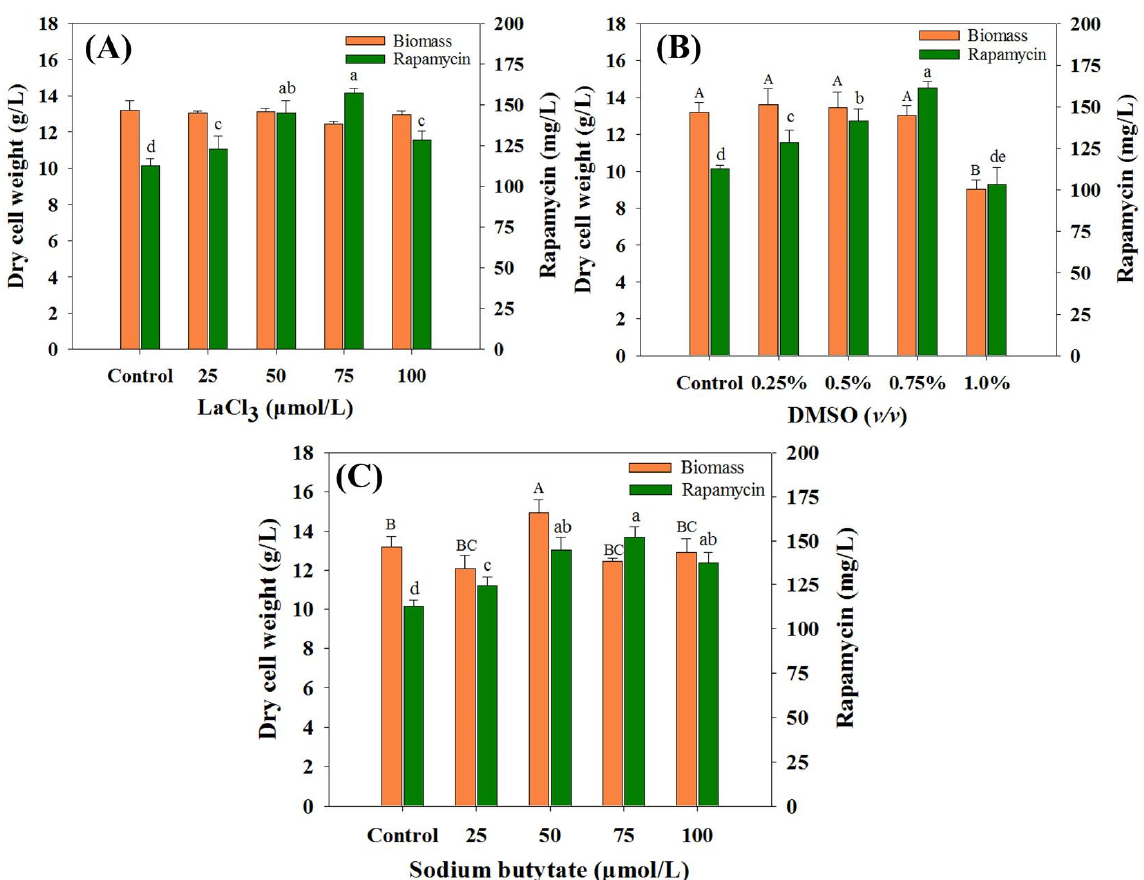
Figure 1. Effects of chemical elicitors on biomass and rapamycin yields. ( A ) Dimethyl sulfoxide (DMSO), ( B ) LaCl 3 , ( C ) sodium butyrate (SB). The final biomass and rapamycin contents were de- termined after seven days of fermentation. The significant difference levels ( p < 0.05) of biomass and rapamycin contents among the different concentrations of each chemical elicitor were marked with uppercase (biomass, e.g., A, B) and lowercase (rapamycin, e.g., a, b) letters, respectively.